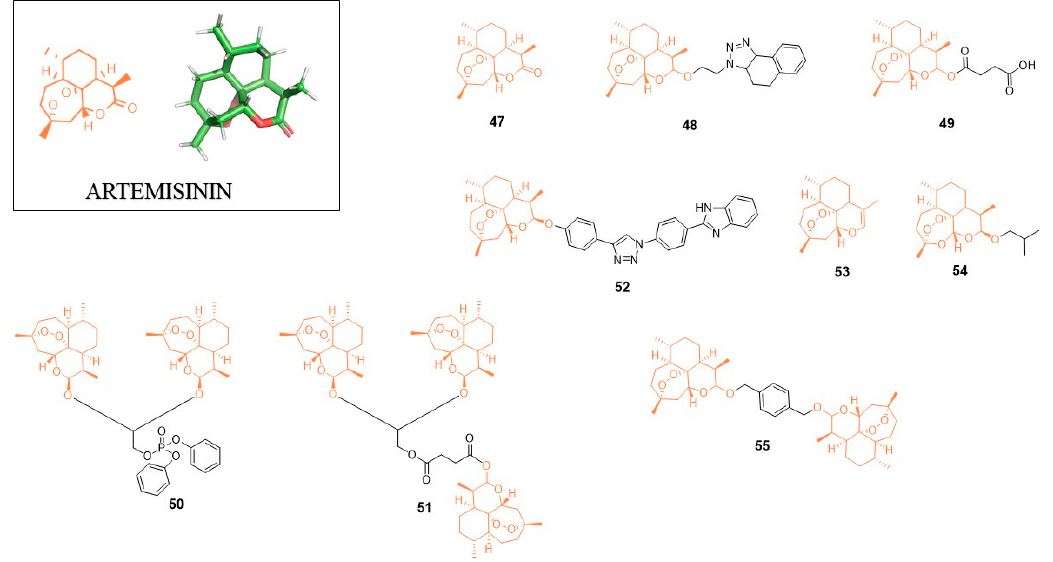
Figure 5. Artemisinin derivatives with antiviral activity.